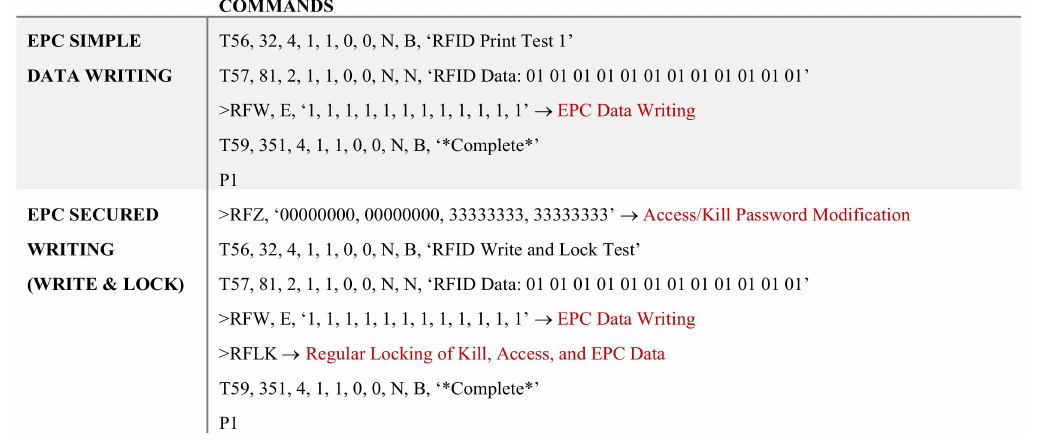
Figure 6. The Bixolon SLP-TX400 RFID code examples for writing and secured writing